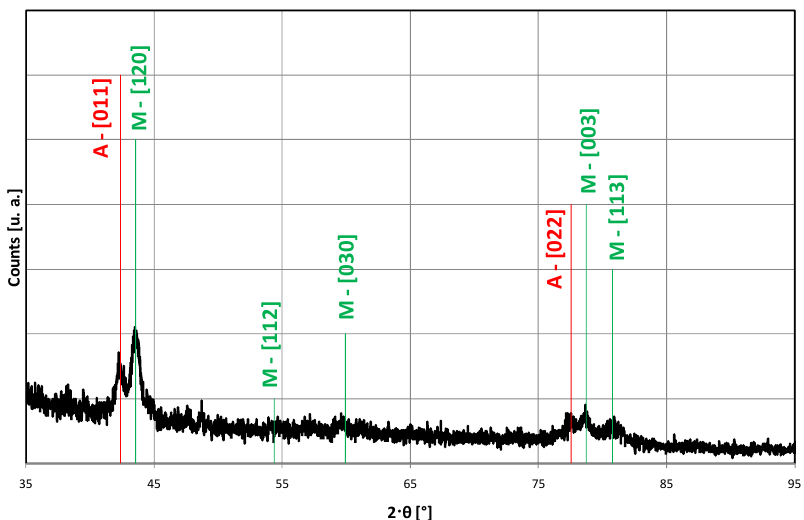
Figure 11: X-Ray spectra of obtained from unloading from  g =10% to  g =5%.